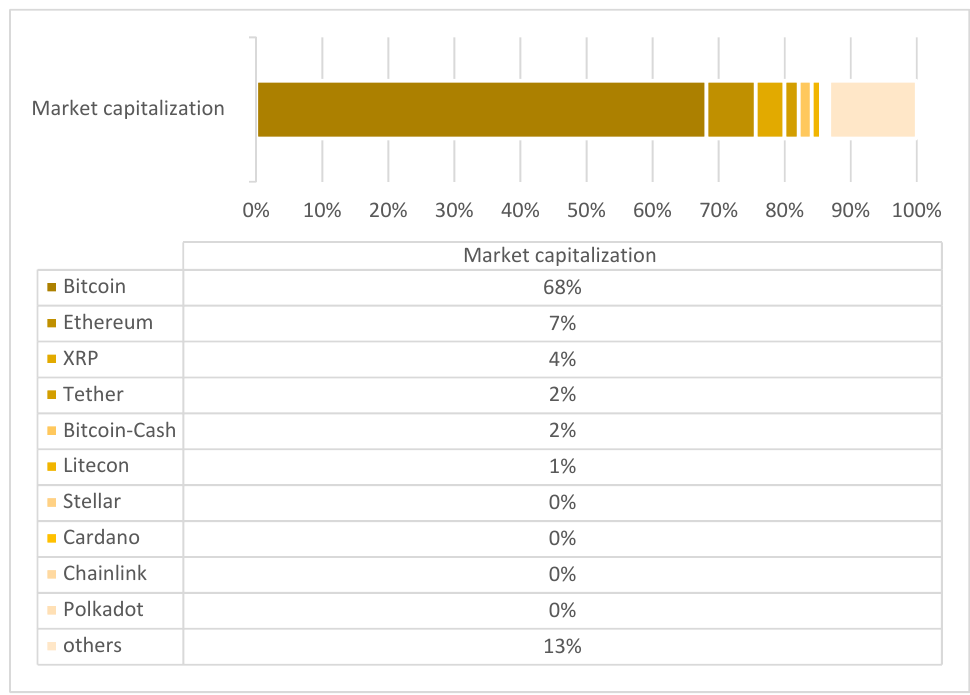
Figure 4. The market capitalization on cryptocurrency market (%).